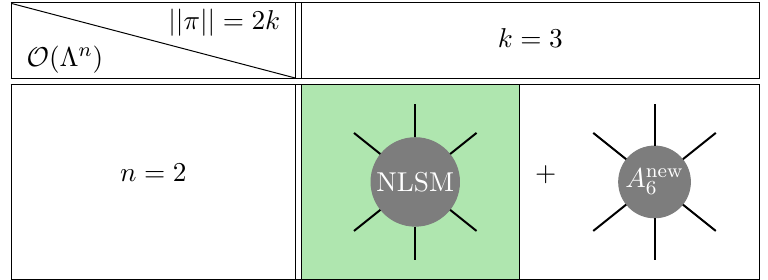
Table 4 . Six-point amplitude for 3 pairs of pions — Green cells contain amplitudes generated by eq. (3.1). The additional contribution at O (Λ 2 ) is required for double-copy consistency of the full vector-pion